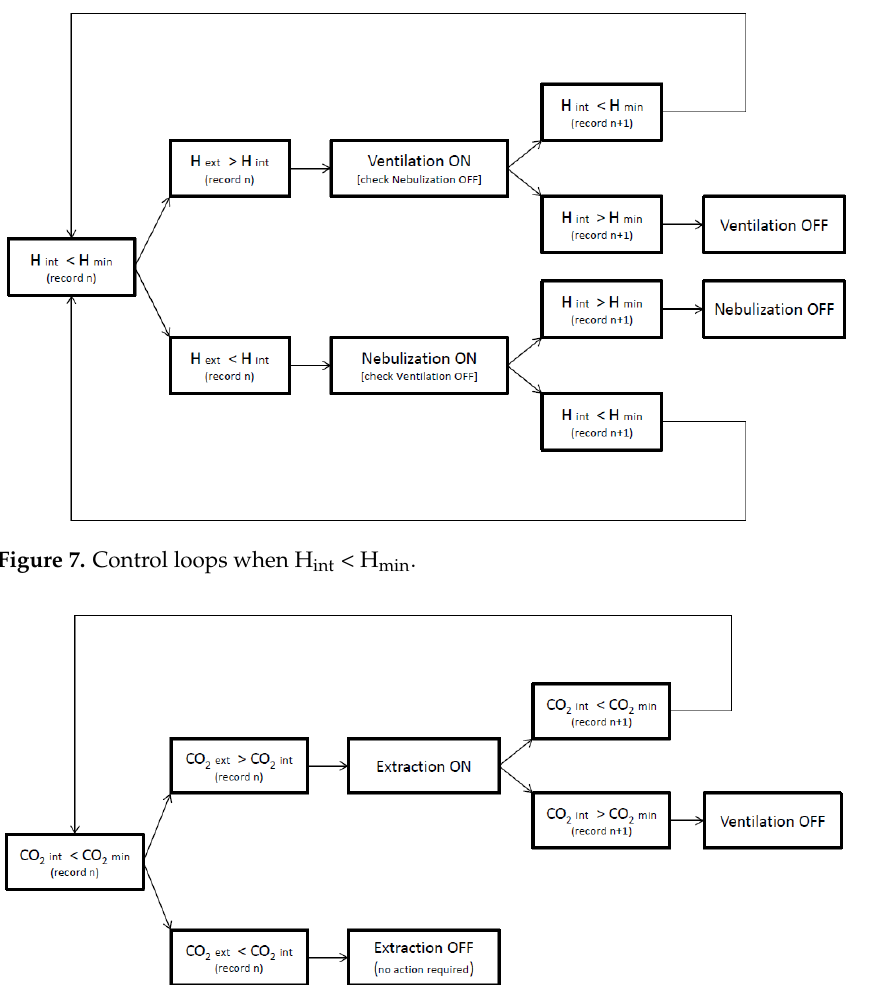
Figure 6. Control loops when H int > H max .